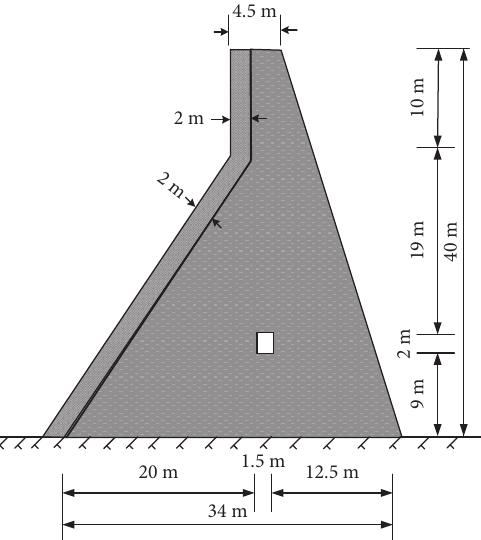
Figure 3: Geometry of the studied concrete